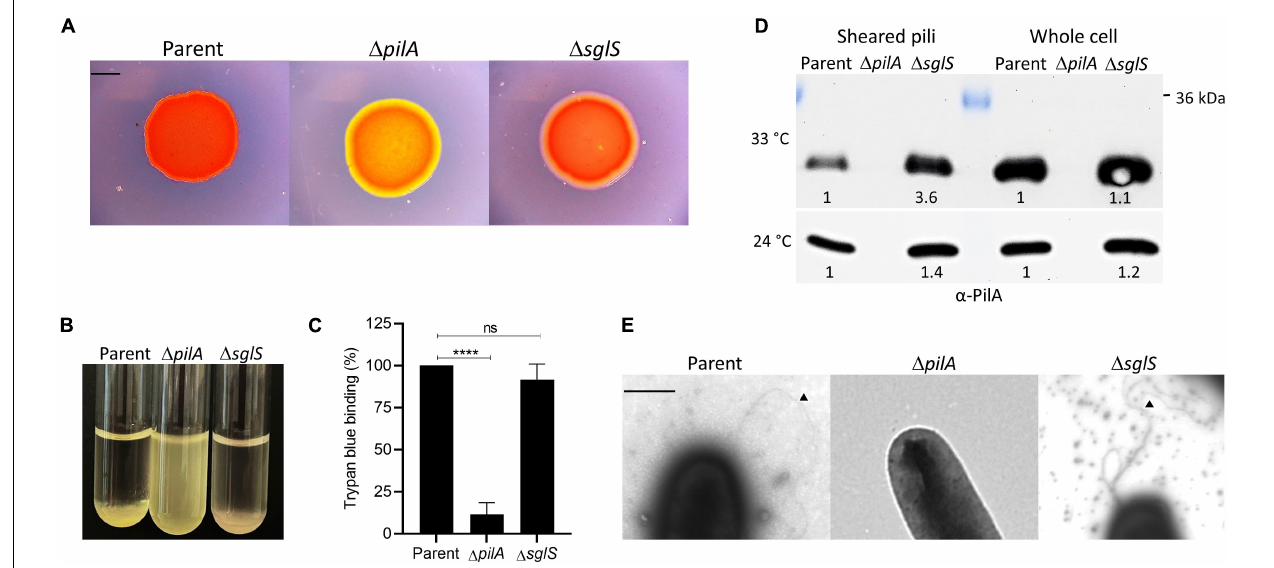
FIGURE 3 | Exopolysaccharide and Tfp production by (cid:49) sglS mutant compared to DK1217 parent. (A) Congo red binding where of PilA mutant serves as an EPS − control (yellow-orange color). Scale bar, 2 mm. (B) Clumping assay where parent is a positive control and (cid:49) pilA mutant is a negative control. (C) Quantitative assay of trypan blue binding to EPS. Percent dye bound calculated relative to the cell-free control and parent strain. (D) Pili shear assay where pilin ( ∼ 24 kDa) detected by immunoblot with α -PilA antibody at two temperatures. Pilin from whole cell fractions also shown. Band intensities measured by KwikQuant imager (Kindle Biosciences LLC) and relative intensities to parent shown. Representative blots shown where equal amounts of cell material was loaded. (E) TEM micrographs of cell poles and pili. Black triangles mark pili. Scale bar, 0.5 µ m. Ns, not statistically significant; ****, p < 0.0001 as determined by unpaired t